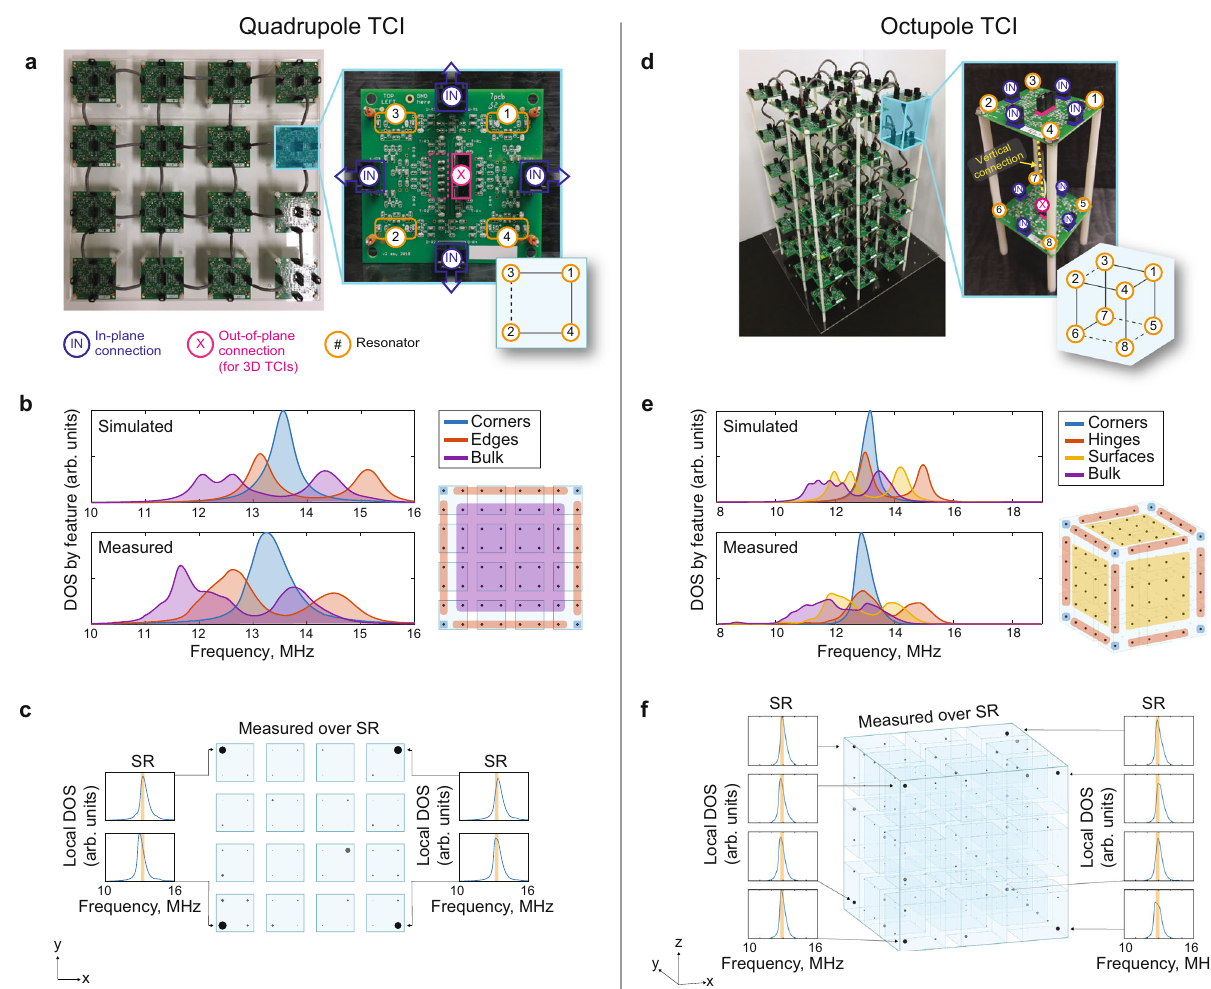
Fig. 2 Implementation of modular quadrupolar and octupolar TCIs. Photographs of the ( a ) quadrupolar and ( d ) octupolar TCIs, including zoomed-in views of the individual unit cells. The inset connectivity diagram represents the tight-binding model within the unit cell, where the dashed lines indicate negative coupling, which implements the π fl ux in each plaquette. b Measured density of states (DOS) averaged over sites that lie on the corresponding feature groupings for the quadrupolar TCI. e Measurements of DOS for the octupole TCI averaged by feature grouping, similar to ( b ). c Spatial map of the mode density at each site over the highlighted spectral range (SR: 13.1 – 13.4 MHz), which corresponds to where the corners have the highest mode density and where the edge and bulk spectra are gapped. Each site is represented as a circle with radius proportional to the local mode density. f Similarly to ( c ), we show the mode density at each site for an octupolar TCI excited over the highlighted spectral range (SR: 12.75 MHz – 13.05 MHz). Complete local DOS measurements for all sites in ( c ) and ( f ) are presented in Supplementary Figures S7 and